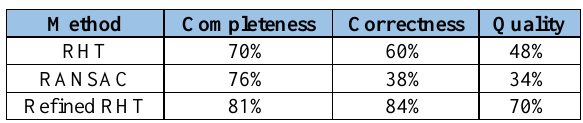
Figure 7. Plane detection results.